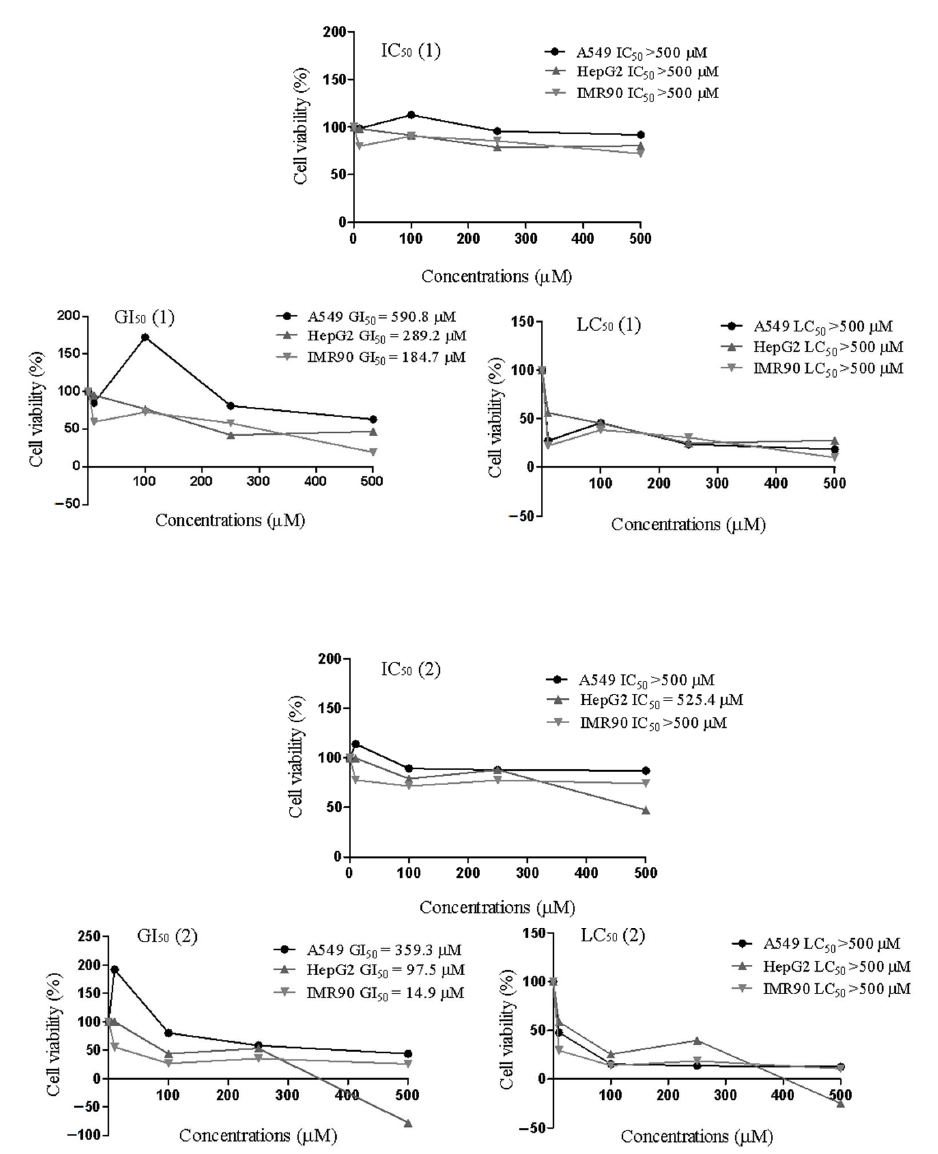
Figure 3. Cell viability of human lung adenocarcinoma epithelial (A549), human hepatoma carcinoma (HepG2), and normal human lung fibroblast (IMR90) cells treated with compounds 1 and 2 . Herein, despite their antioxidant effect as pointed out by the DPPH assay, it was clear that both 1 and 2 compounds exerted pro-oxidant behavior (Figure 4) by inducing reactive oxygen species (ROS) generation in non-cancer (IMR90) and malignant (A549) cells, which explains their cytotoxicity observed in cell viability assay. It is known that if ROS levels increase dramatically to toxic concentrations, the JNK (c-Jun NH2-terminal kinases) pathway can be activated, resulting in apoptosis and cell death [22]. By contrast, Sobeh (2019) reported that the methanolic extract of E. uniflora leaves present noticeable antioxidant properties by reducing the intracellular ROS levels and by increasing the re- duced glutathione (GSH) content in HaCaT cells [24]. This disagreement may be explained by the chemical profile of a crude extract compared to the isolated compounds 1 and 2 . In this case, the antioxidant effect may have occurred due to the synergistic effects between the bioactive compounds the crude extract, while the oxidative activity shown herein was related to the individual abilities of compounds 1 and 2 . Indeed, our results highlight the high cytotoxicity of compounds 1 and 2 , acting in a more intense way against